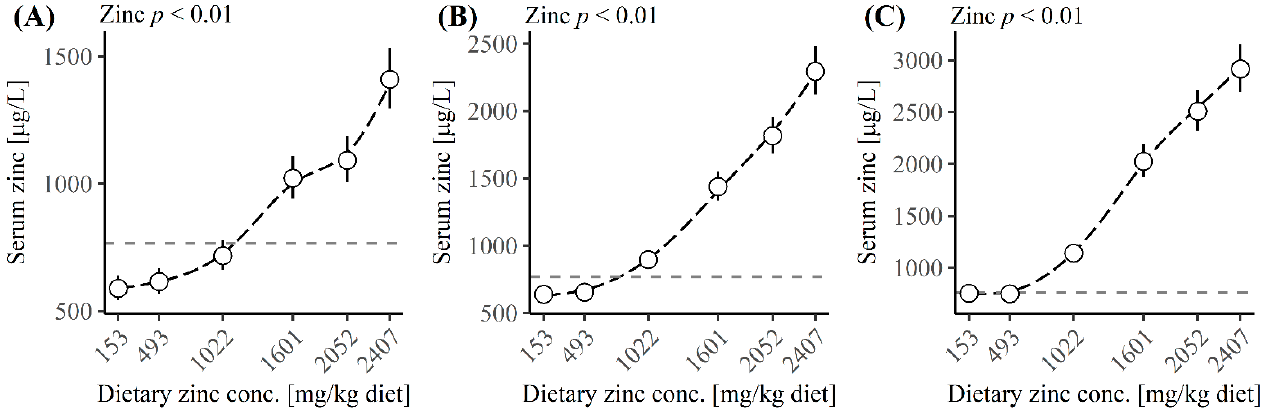
Figure 2. Average serum zinc concentration [µg/L] at ( A ) day 7 post-weaning (PW), ( B ) day 14 PW, ( C ) day 21 PW. The black dashed lines illustrate the effect of dietary zinc concentration, while the grey dashed line illustrates the serum zinc concentration at day 0.